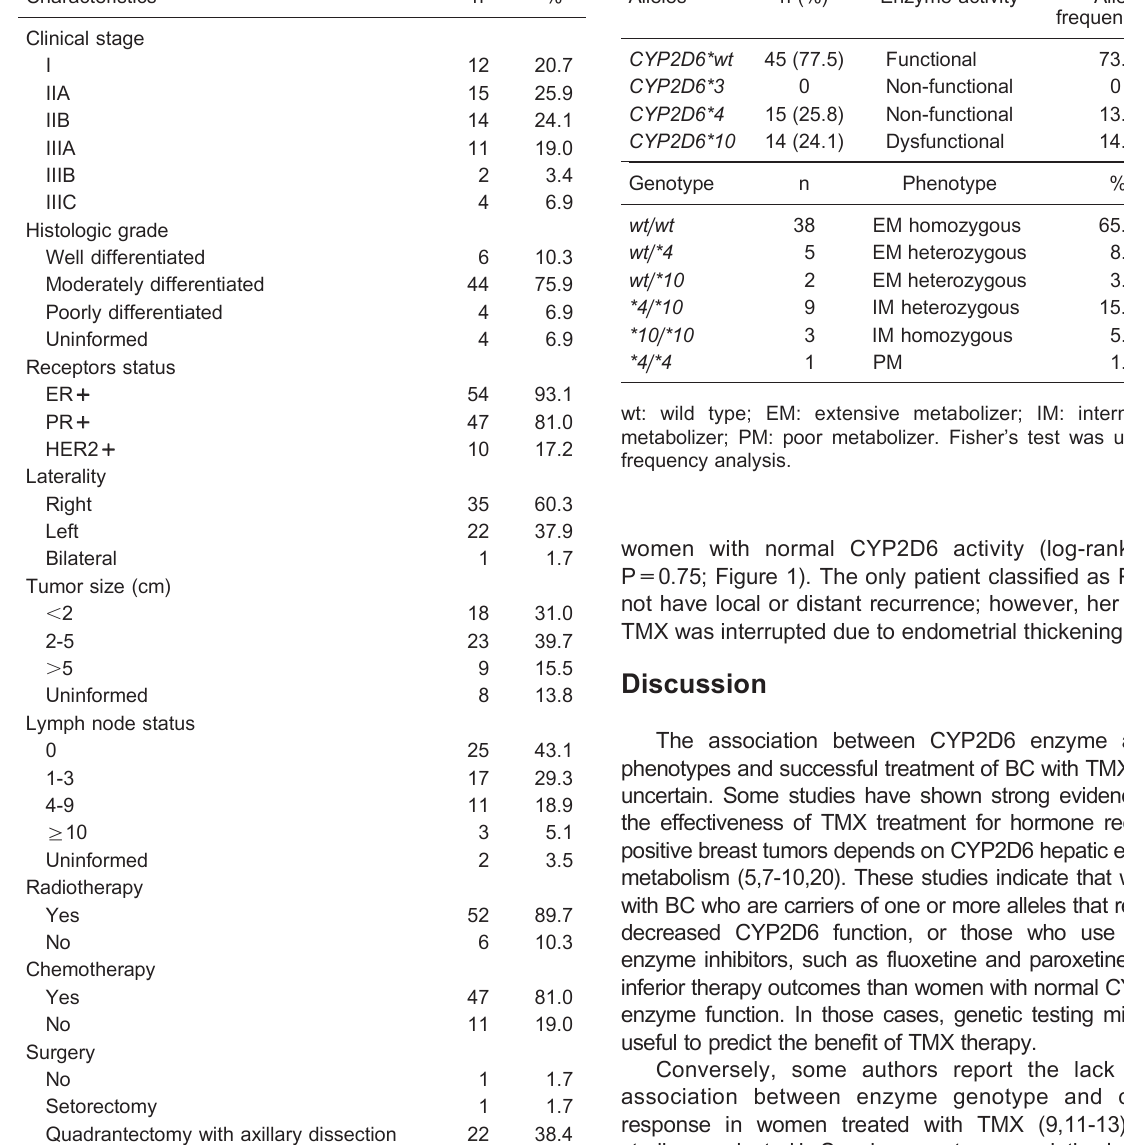
Table 2. Clinical features, tumor characteristics, and treatment of patients. Characteristics